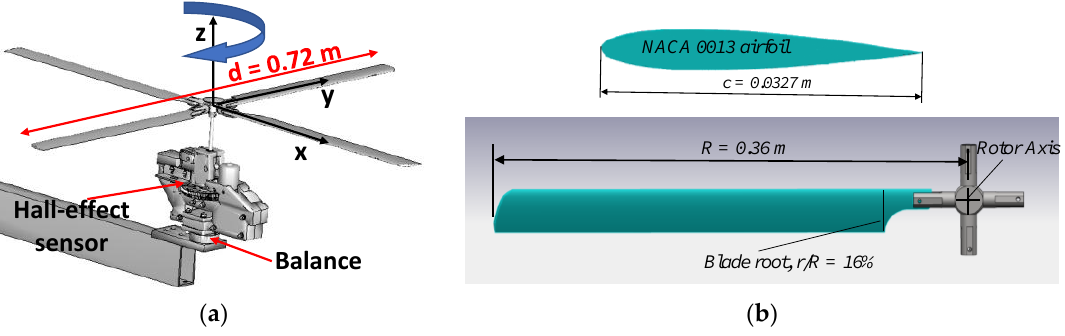
Figure 1. ( a ) Rotor test rig; ( b ) airfoil and planform blade drawings, (reprinted from ref. [24]). The force and moments produced by the rotor rig were measured by a six components balance (ATI MINI40). The detailed characteristics in terms of full scale and accuracy are summarized in Table